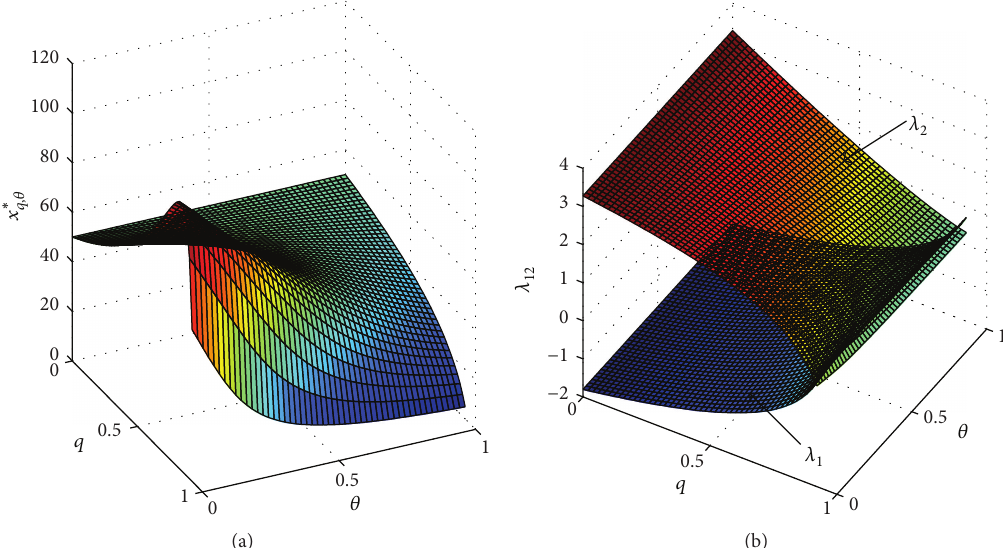
Figure 3: The effects of instant killing rate 𝑞 and pesticide application time 𝜃 on the values of 𝑥 ∗ 𝑞,𝜃 and its stability. The parameter values are as follows: 𝑇 = 10 , 𝑇 ℎ = 0.5 , 𝐾 = 50 , 𝛿 = 0.3 , 𝑞 = 0.1 , 𝛾 = 1 , 𝛼 = 0.007 , and 𝑟 = 2.8 .